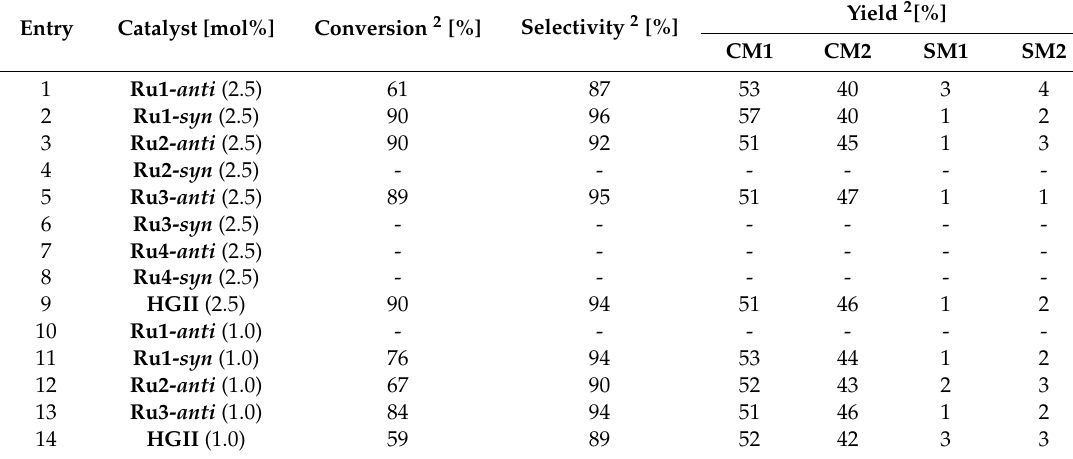
Table 2. CM of 1 with 2 in the presence of Ru1 – Ru4 and HGII 1